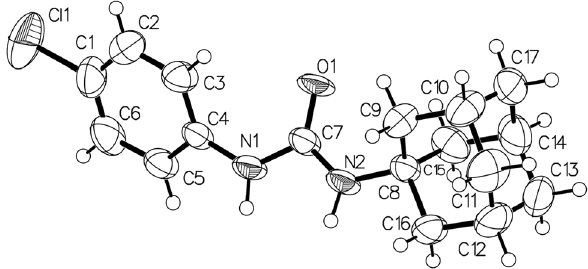
Table  : Data collection and